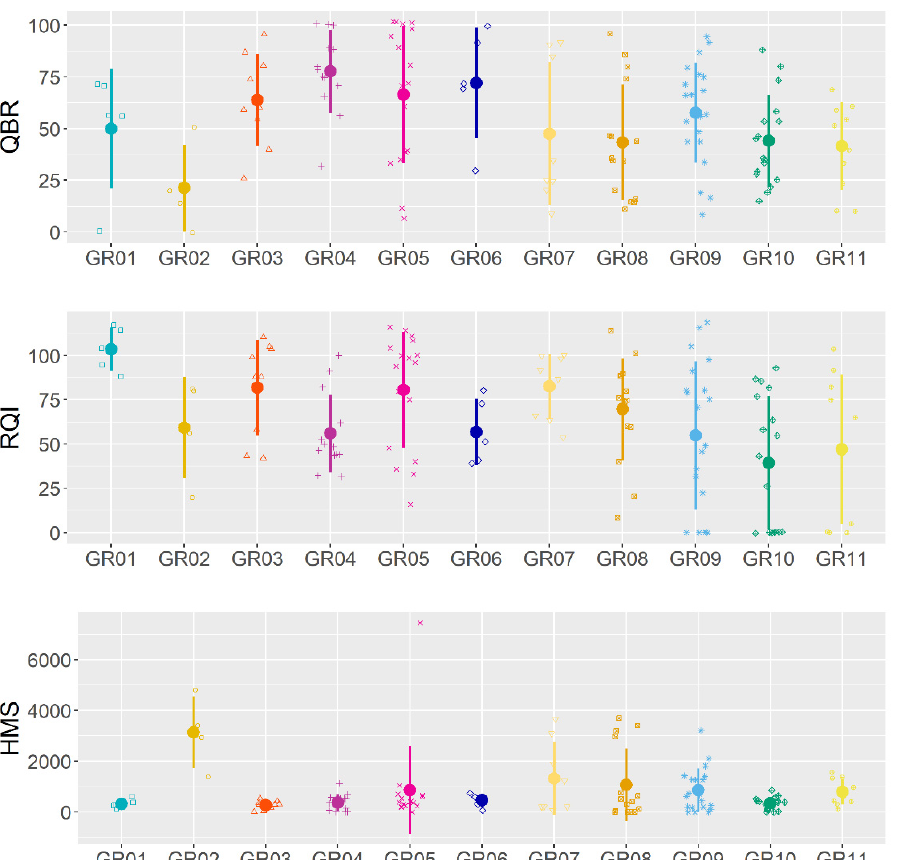
Figure 6. Strip charts (1D scatter plots) of QBR, RQI and HMS per Water District. Mean values and standard deviations are also shown.